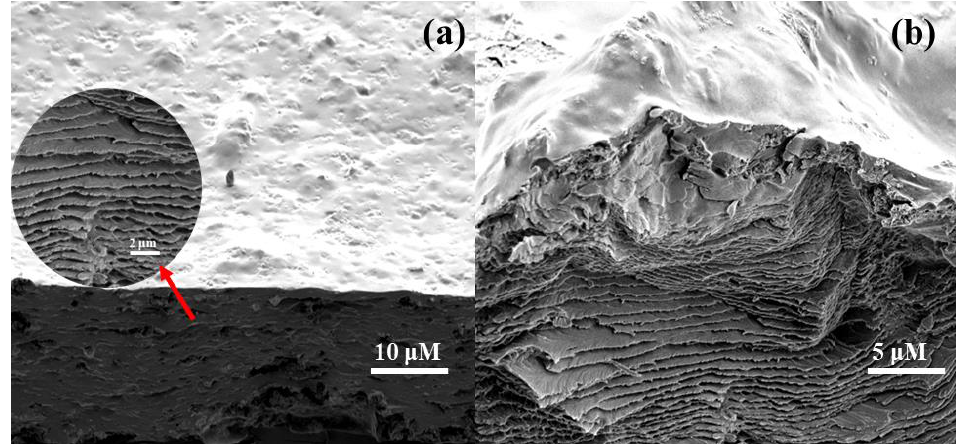
Figure 11. SEM micrographs of hydrogels ( a ) surface and ( b ) cross-section. Inset hydrogel cross-section.